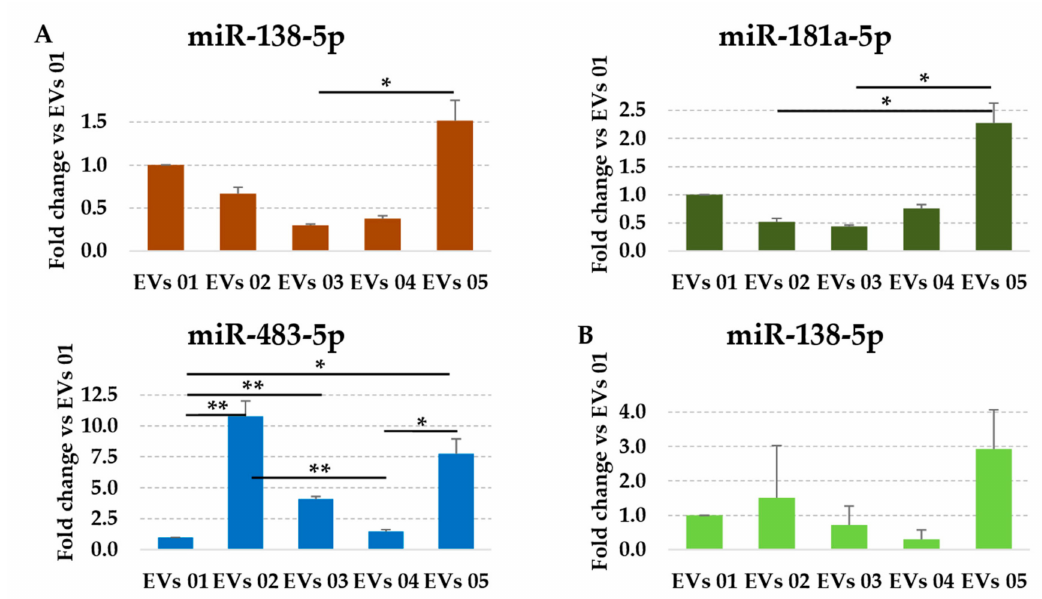
Figure 4. E ff ects of RGs on the abundance of miRNAs di ff erentially expressed between iASC-EVs samples. ( A ) After normalization with stable miR-26a-5p / 16-5p, out of 48 assayed miRNAs only miR-138-5p, miR-181a-5p, and miR-483-5p showed significant di ff erential expression ( ± 4 fold changes) between samples. iASC-EVs 01 set as 1; * p -value < 0.05 and ** p -value < 0.01. ( B ) Using miR-103a-3p / 425-5p on miR-138-5p, both expression ratios (EVs 02 vs. 01 or EVs 03 vs. 04) and significance (EVs 03 vs. 05) are lost.